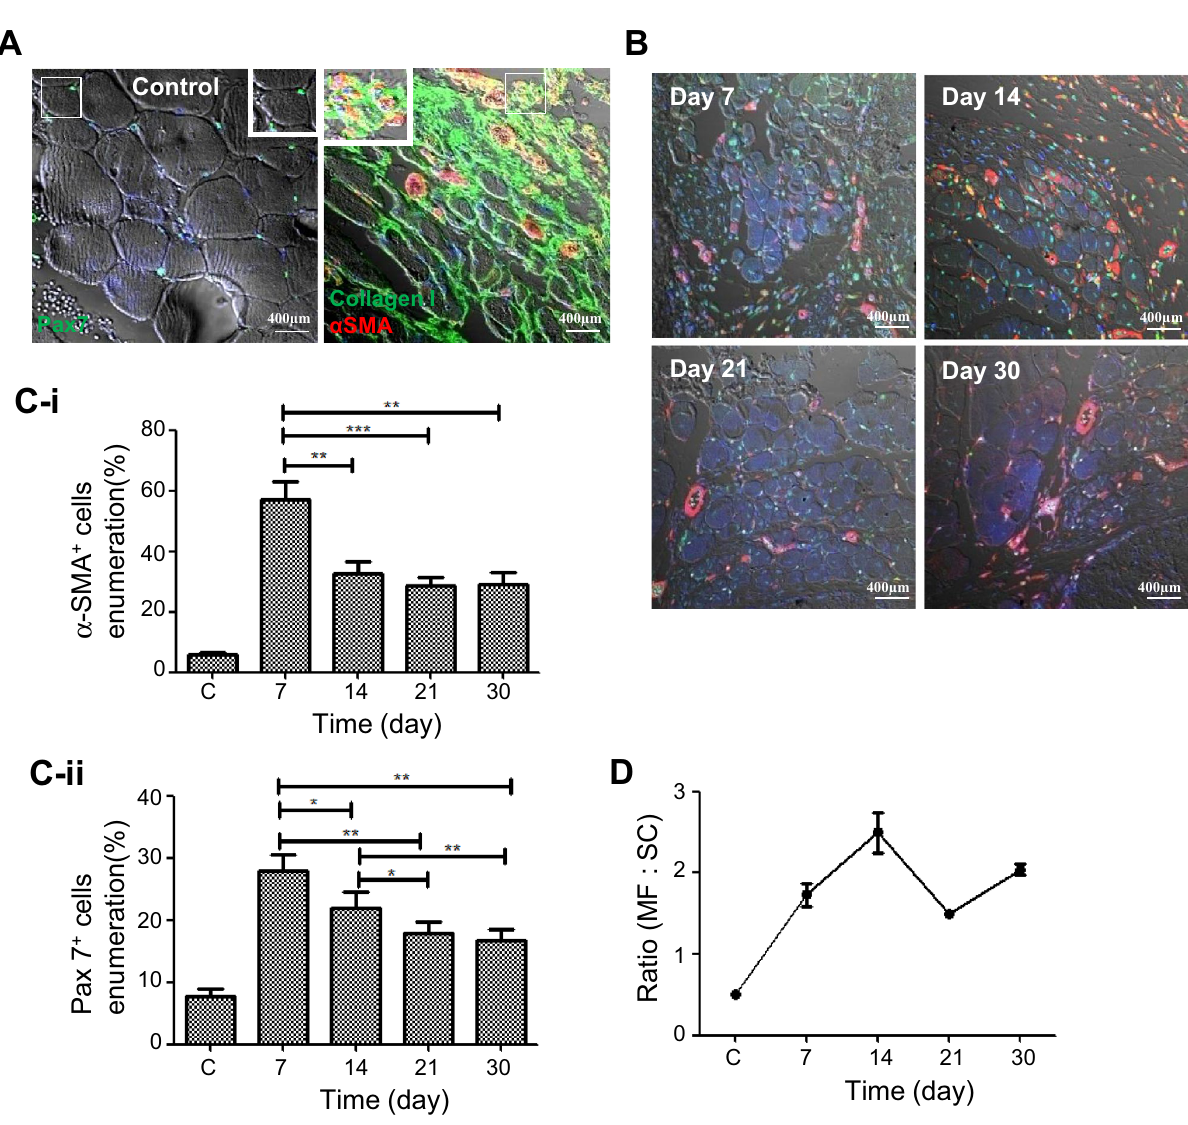
Figure 2. Change in MFs and SCs number within the wounded area. ( A ) Confocal images show the pathological features of the normal and fibrotic muscle. Pax7 expressing SCs are present in the sublaminar space of the normal muscle (left), whereas αSMA expressing MFs are associated with collagen type I deposits in the ECM (right) of fibrotic muscle. ( B ) Confocal images (bright field) show Pax7 + (green) SCs and αSMA + (red) MFs at different time points of the injury. ( C-i ) and ( C-ii ) Enumeration of MFs and SCs on the basis of the expression of αSMA and Pax7, respectively, was established by morphometric analyses of 21 fields (40× magnification) using the ImageJ software. ( D ) Ratio of MFs and SCs at different stages of the injury. Data were presented as mean ± SEM. ***p < 0.001 , **p < 0.01, *p <